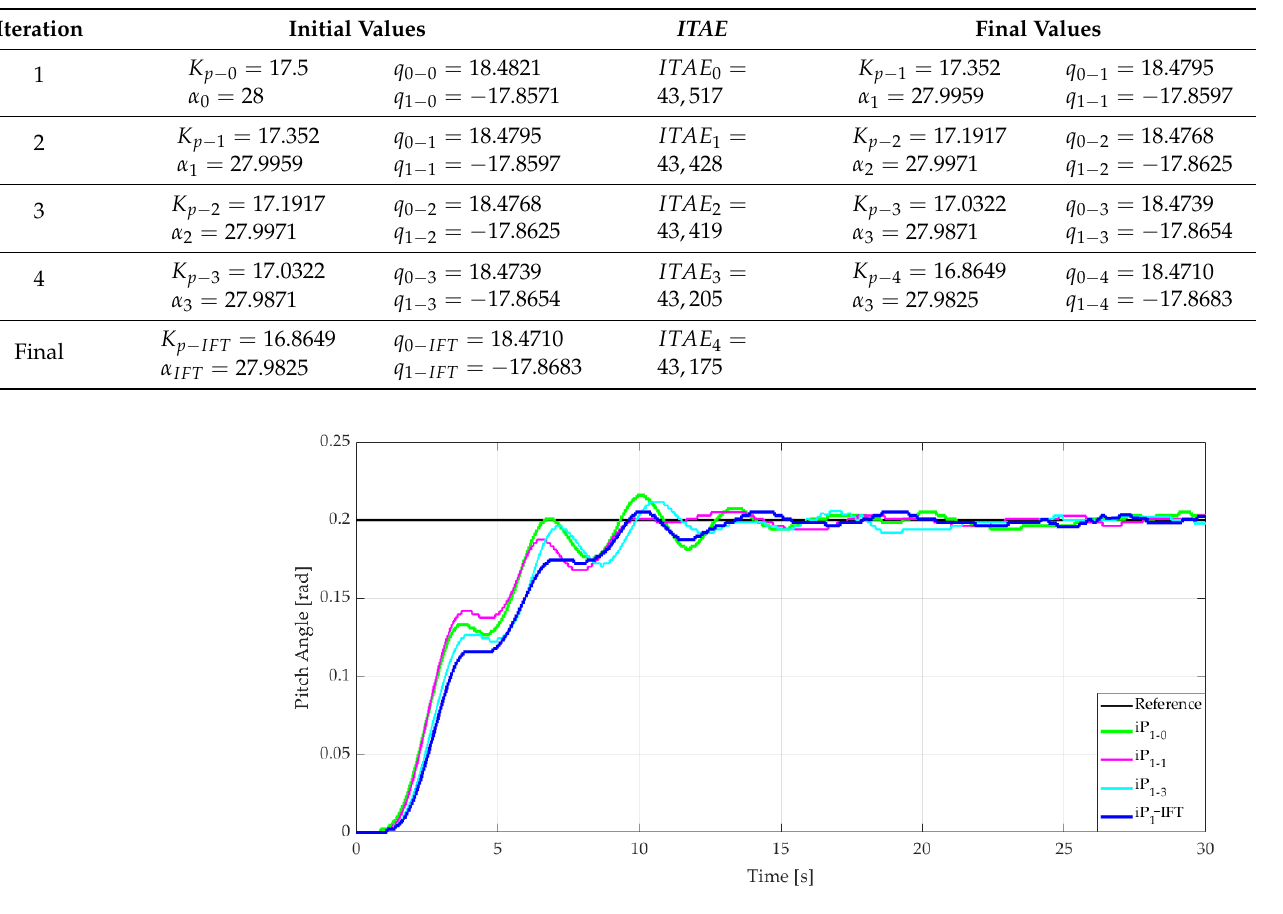
Figure 5. Control system responses with the iP 1 controller during the tuning with the IFT algorithm.